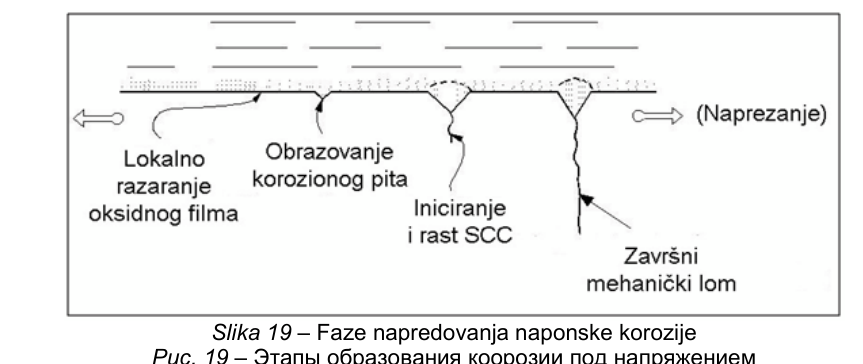
Figure 19 – Stages of progression of stress corrosion Prskotina pri naponskoj koroziji može da se širi transkristalno (kroz same kristale) i interkristalno (duž granica kristala).